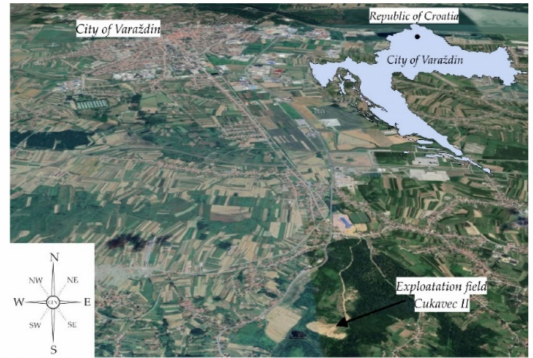
Figure 1. Research was carried out on the exploitation field Cukavec II near the city of Varaždin [2,4].